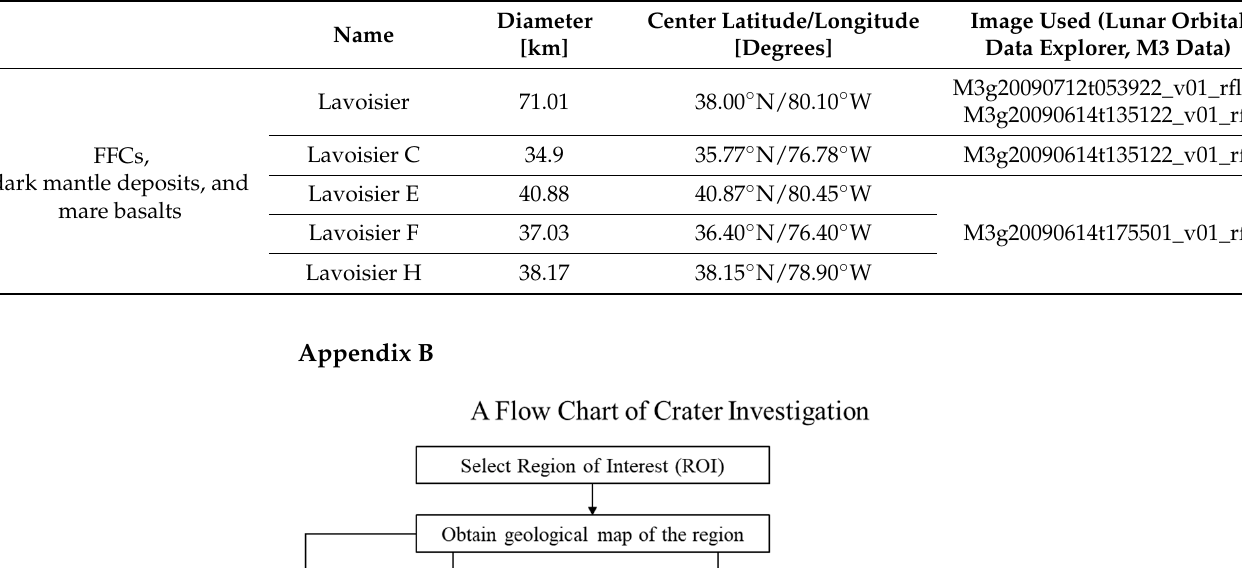
Table A1. The floor-fractured craters (FFCs) in the study area that include the dark mantle deposits and mare basalts list in Figure 1 (IAU Gazetteer of Planetary Nomenclature_Moon).